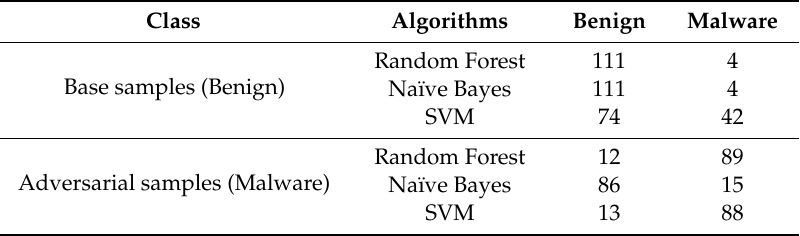
Table 7. Classification result of base samples and adversarial samples with the structure feature